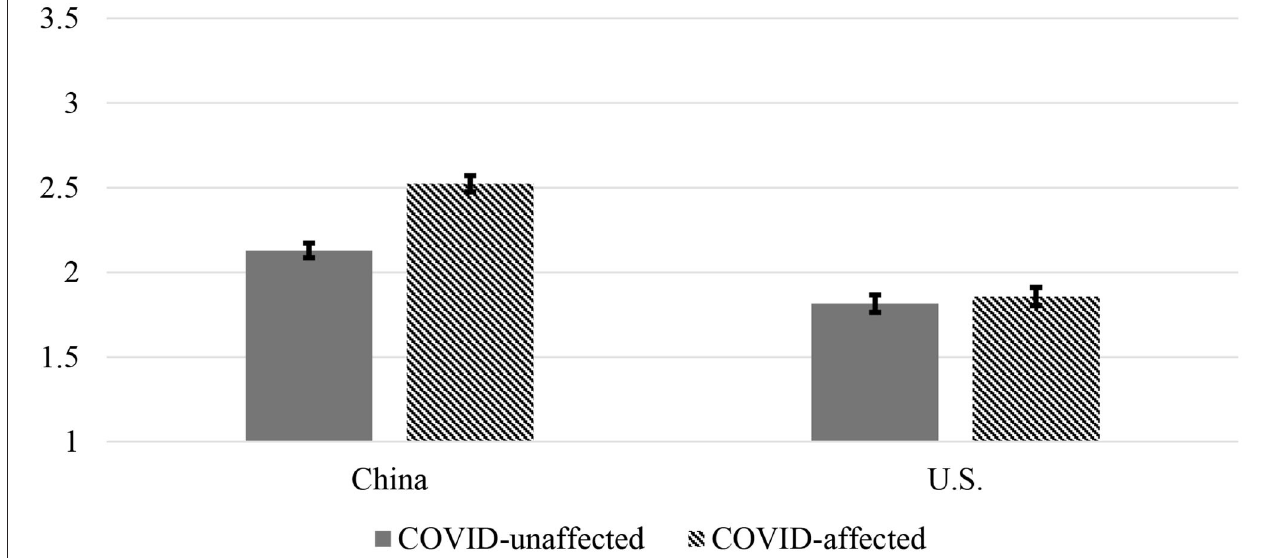
FIGURE 5 | ANOVA results for country by COVID-affected area interaction on aggression against doctors (COVID-19 Scenarios) (Study 2). Error bars indicate standard